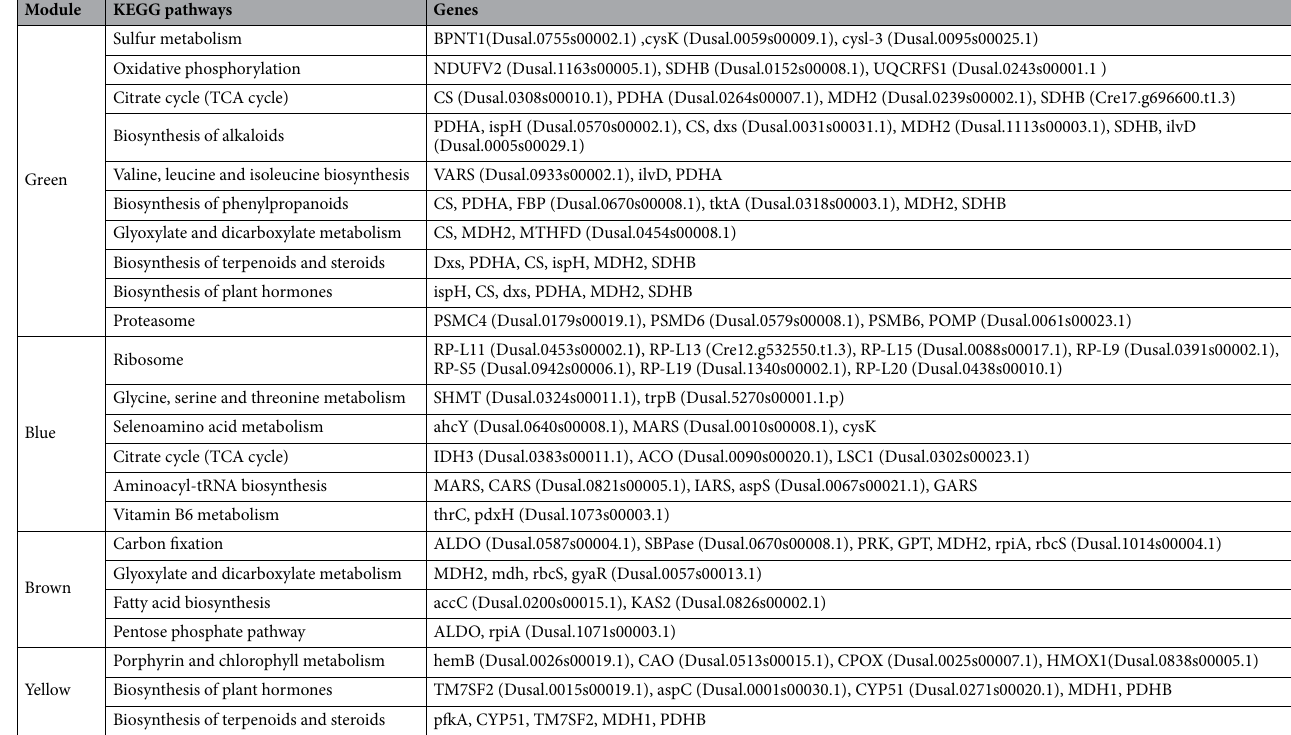
Table 2. Resulting KEGG pathways enriched in non-preserved modules.